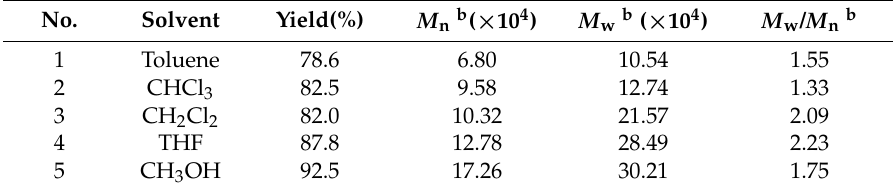
The poly( DoDHPA ) which obtained using the chiral [Rh(L-alaninate)(cod)]